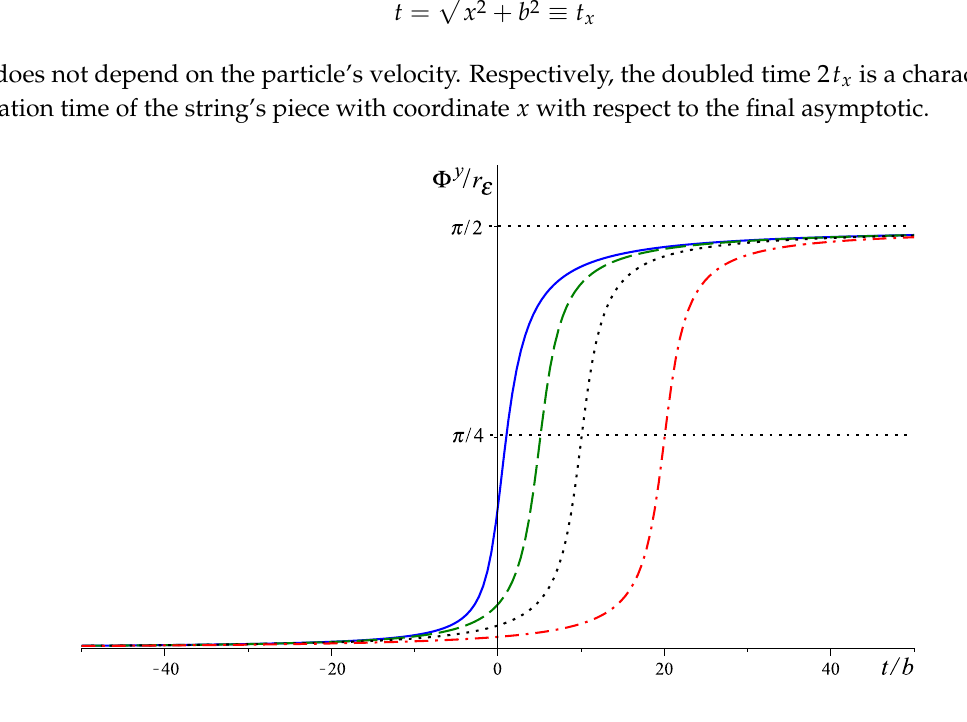
Figure 2. Transverse string perturbation (in units r E ) versus time (normalized by b ) for x = 0 (blue solid line), x = 5 b (green dashed line), x = 10 b (black dotted line), x = 20 b (red dashdotted) for v =